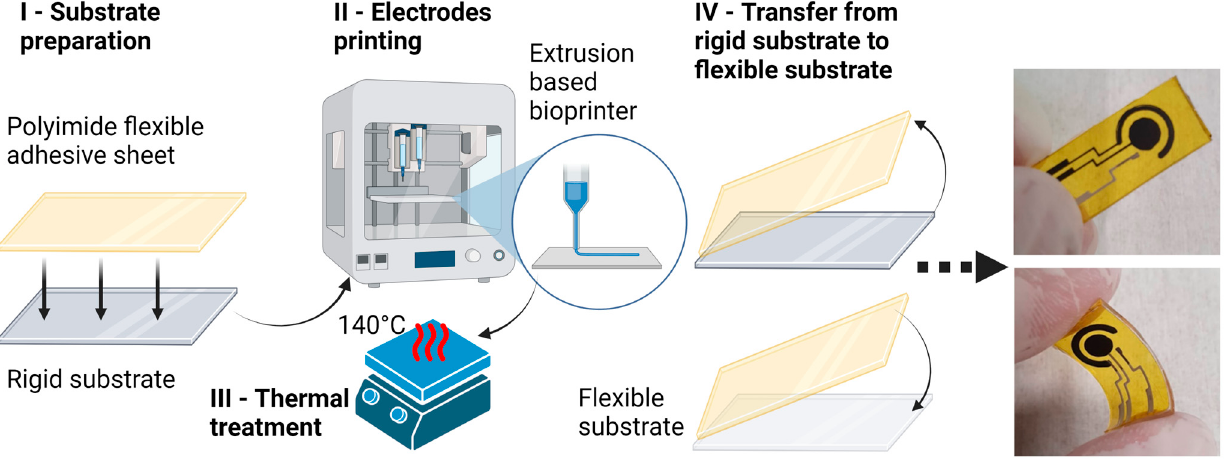
Figure 1. Fabrication process work fl ow.